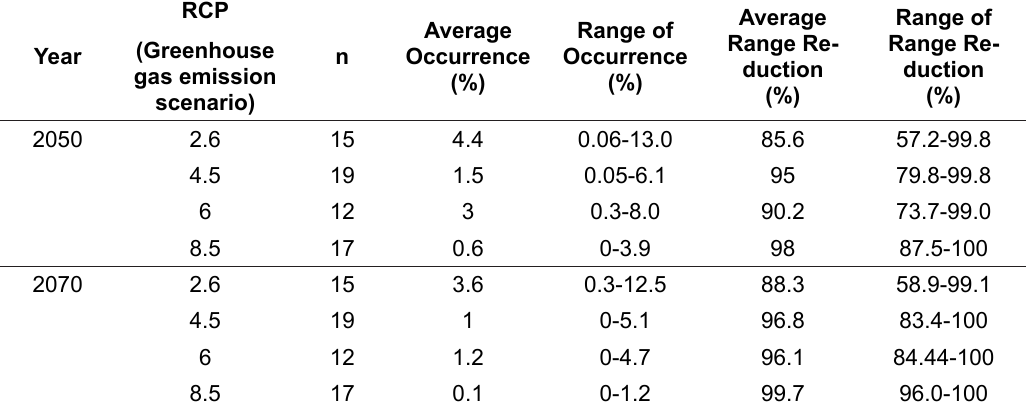
Table 2. The forecasted average and range of woodland caribou occurrence, and forecasted average range re- duction (%) and range of values for the change in range extent of woodland caribou in northern Ontario for mid-century (2050) and late-century (2070) based on 63 climate change scenarios each. Shown are values for four greenhouse gas emission scenarios, representative greenhouse gas concentration (RCP) pathways and the number of models that are available for each scenario and time period